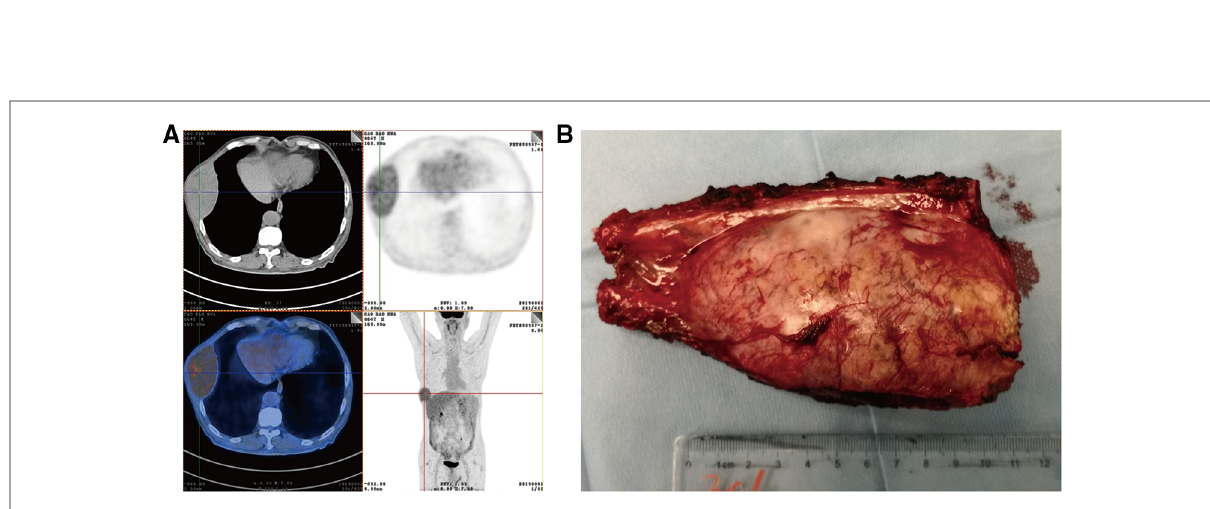
FIGURE 3 ( A ) PET-CT detected a tumor metastasis of approximately 8.9 cm×5.3 cm that was located in right seventh rib. ( B ) By gross appearance, the resected specimen shows a metastatic tumor measuring 11 cm×7 cm×5 cm.